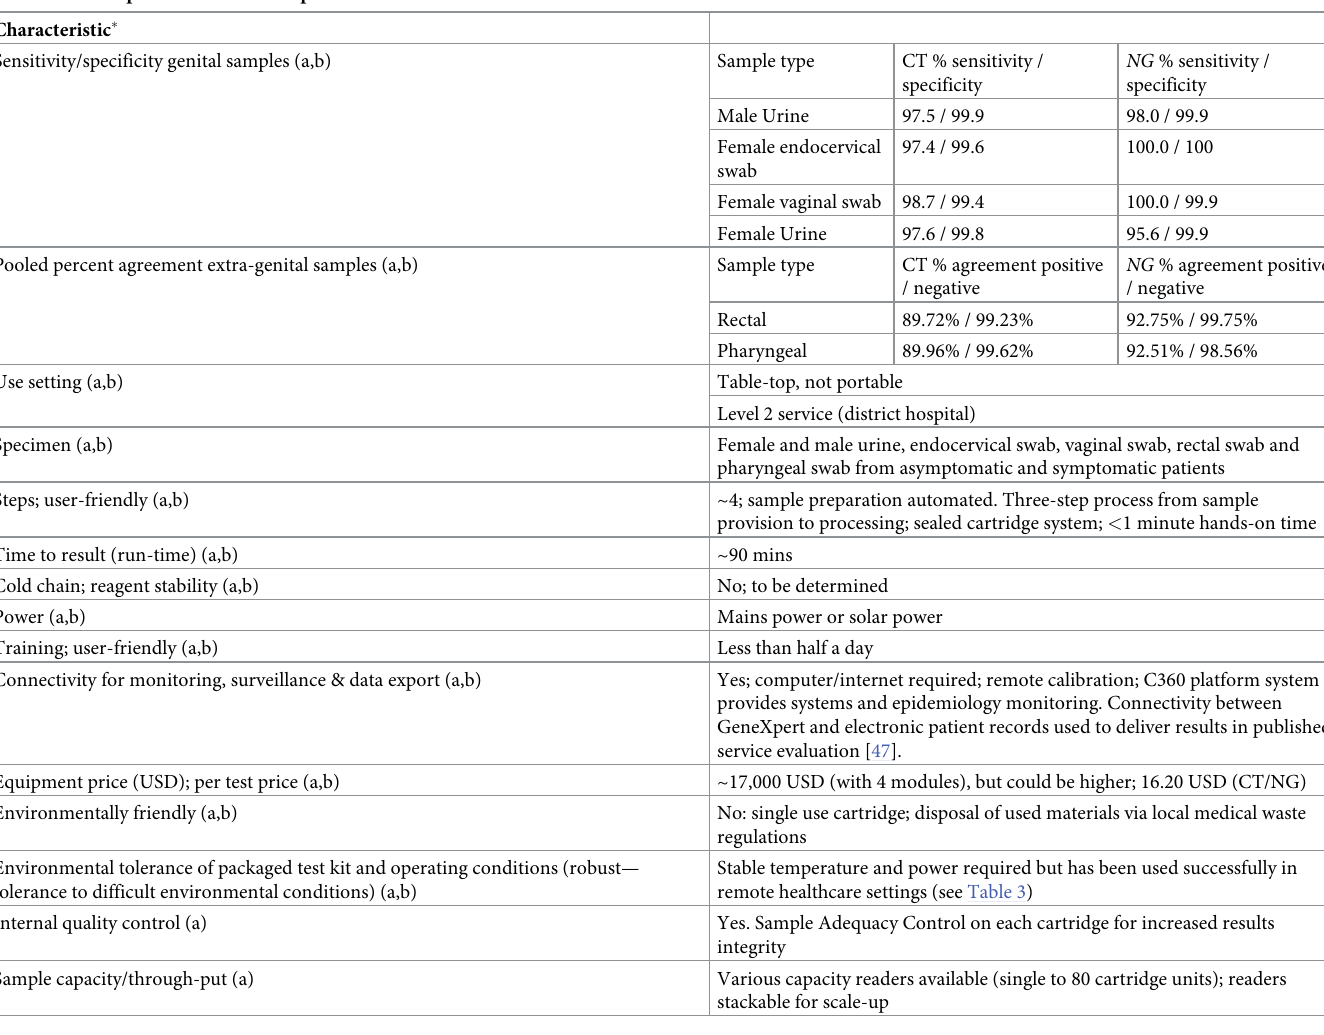
Table 2. The Cepheid CT/NG GeneXpert fulfilment of TPPs and REASSURED criteria. Characteristic